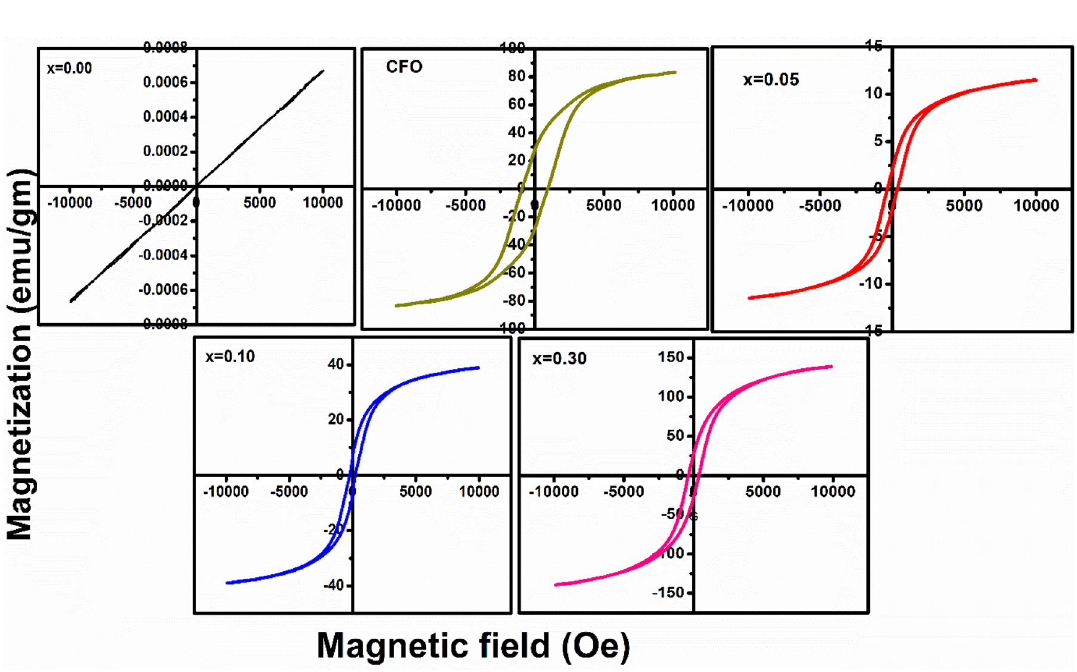
Figure 9. Magnetization (M) versus magnetic field (H) hysteresis loops of (1 − x) BFO–x CFO (CFO, x = 0.00, 0.05, 0.10 and 0.30) samples at room